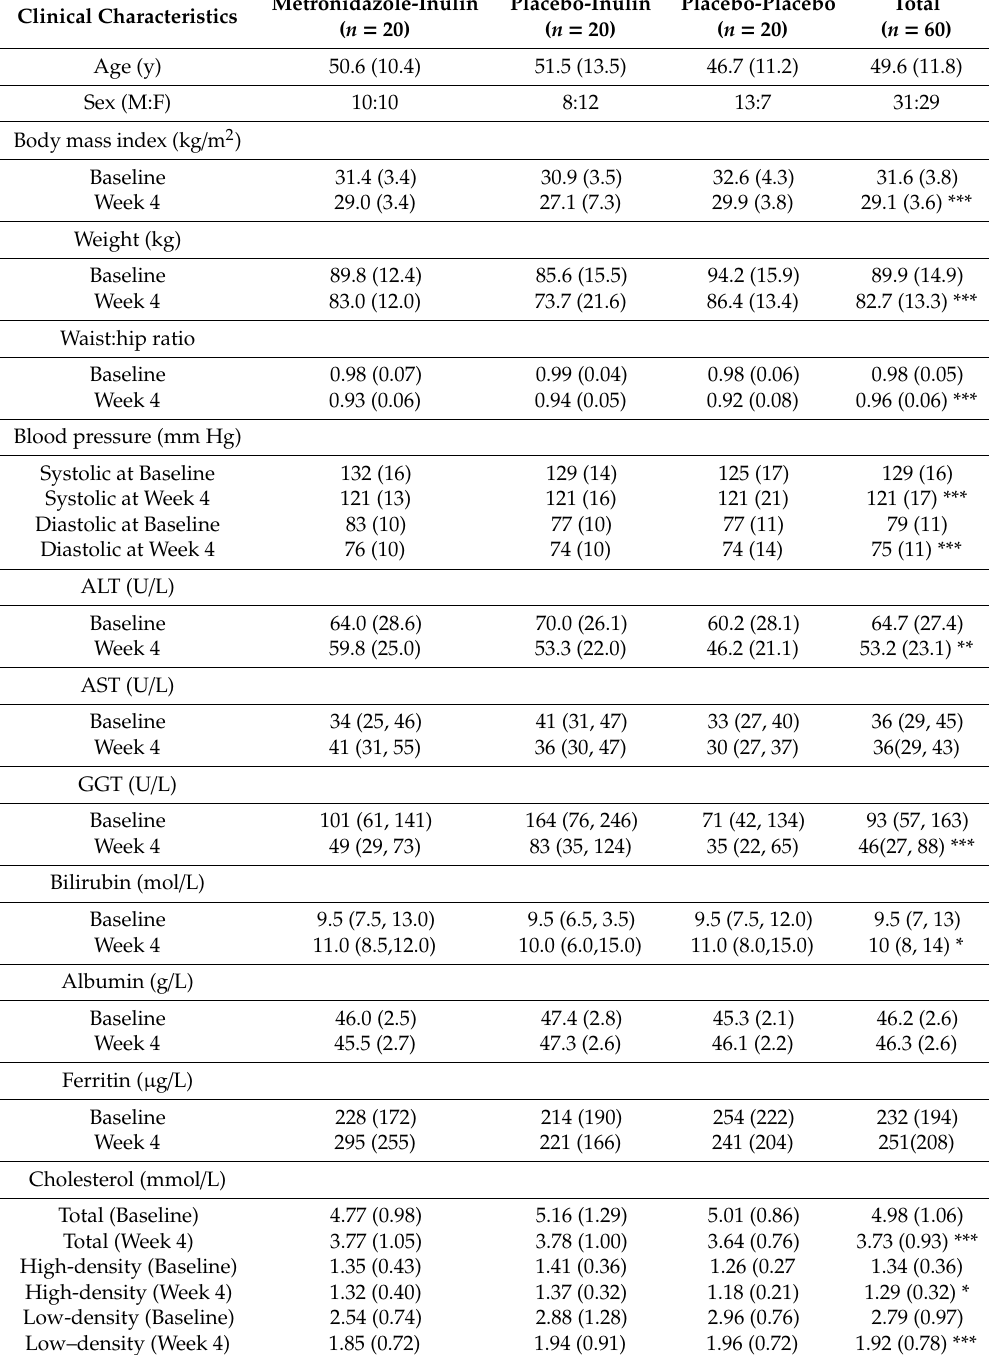
Table A1. Baseline and week 4 characteristics of study